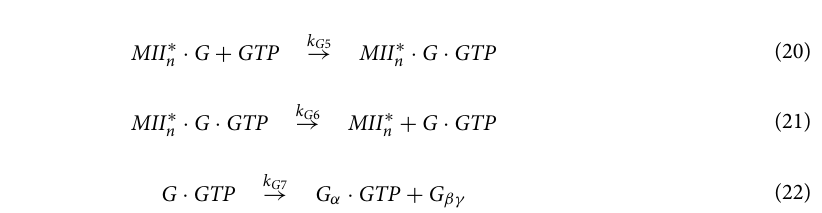
Figure 4. PDE-mediated cGMP hydrolysis in rods and cones. ( A ) The time courses for PDE activities (the number of cGMP molecules hydrolyzed per VP*) in the membrane of carp rods and cones in response to light stimulations (a, 0.024% for rods (open circle); b, 0.46% for cones (open circle)) in the presence of ATP (0.25 mM), cGMP (2500 μM) and either GTP (open closed circle) or GTPγS (filled triangle) determined by biochemical experiments 17,27 ). Corresponding simulation results (solid lines (with GTPγS) and dotted lines (with GTP) in a and b) were superimposed onto the experimental data. The continuous presence of saturating levels of cGMP was assumed for the simulation study, and thus βdark was set to 0. ( B ) Light-induced peak PDE activity as a function of flash intensity in rods (circle) and cones (triangle) either in the presence of ATP (a, 0.25 mM) or without ATP (b) and either GTP (open symbols) or GTPγS (filled symbols) are normalized to maximum values. Simulated PDE activity of the rods and cones reproduced under the corresponding experimental conditions (with either GTP (dotted lines) or GTPγS (solid lines)) were superimposed onto the experimental results. The value for the rate constant, k decay , for cGMP hydrolysis was set to 0 for the simulation of the experimental results obtained with